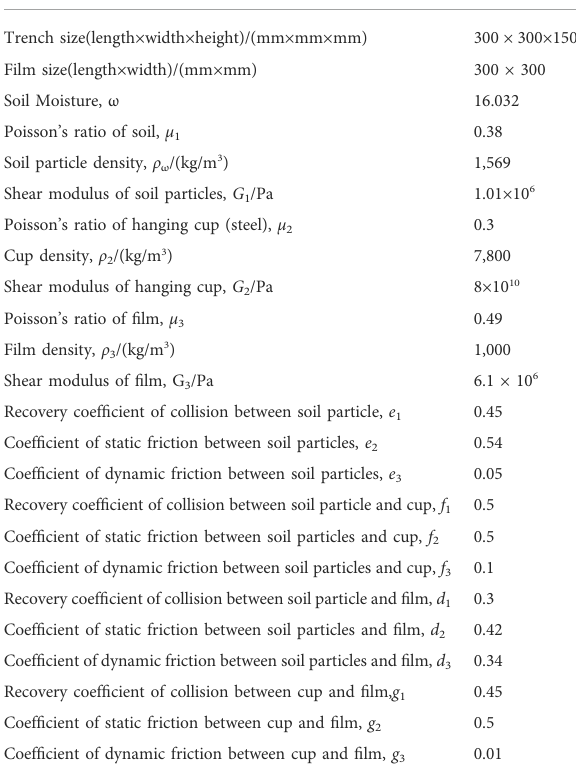
TABLE 6 Simulation parameters of hole forming on plastic fi lm.